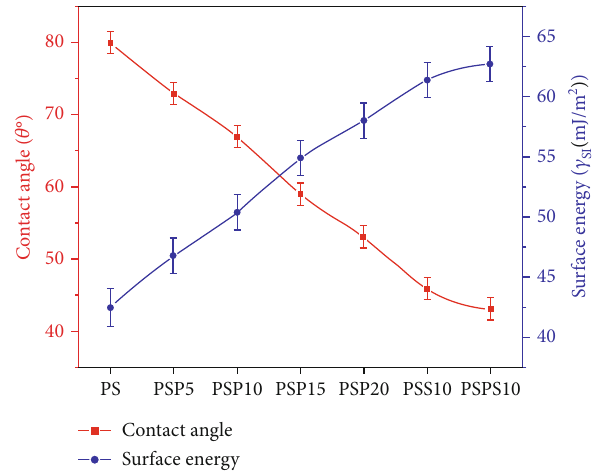
Figure 4: Blend composition and water contact